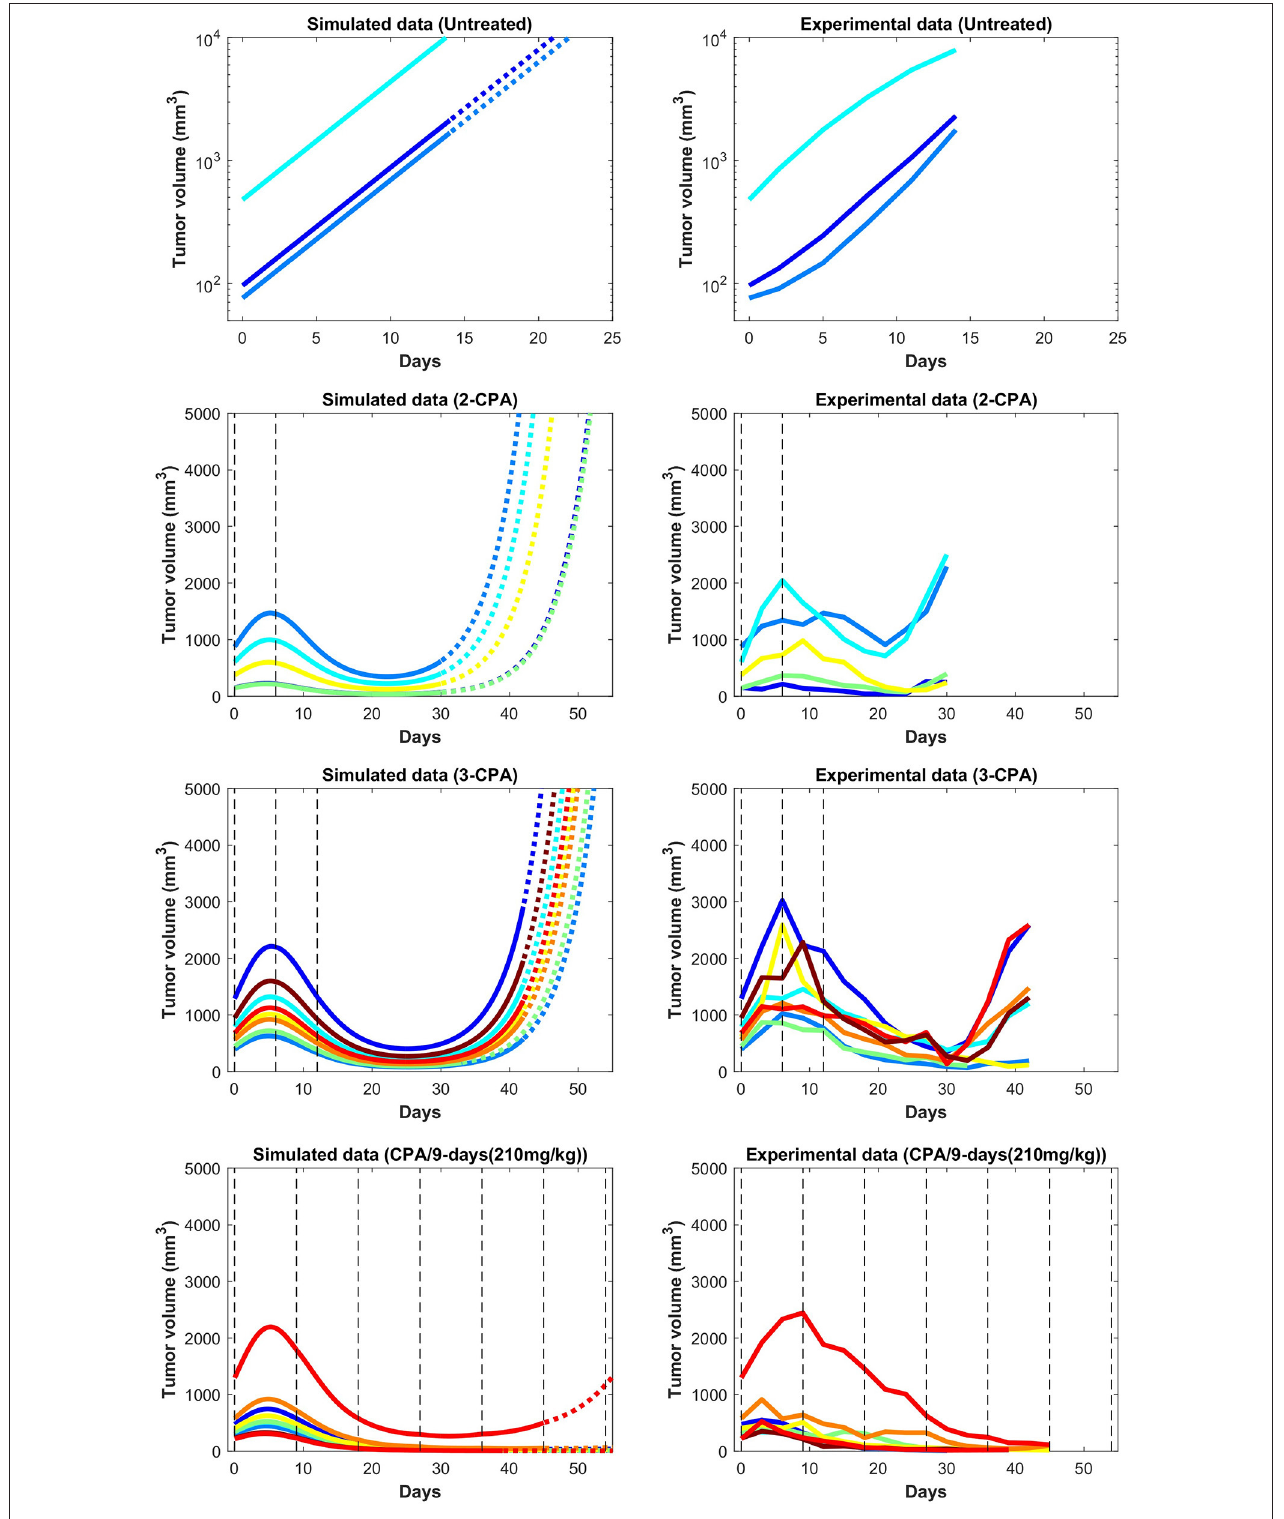
FIGURE 3 | Simulated and experimental growth curves for the scenarios of 1-CPA, 2-CPA, 3-CPA, and doses of 210 mg/kg given every 9 days (CPA/9-days/210). When not specified, CPA doses are 140 mg/kg. Black dashed lines represent the time at which drug treatments are given. Solid lines represent fitted data; dotted lines represent predicted growth curves extrapolated from the